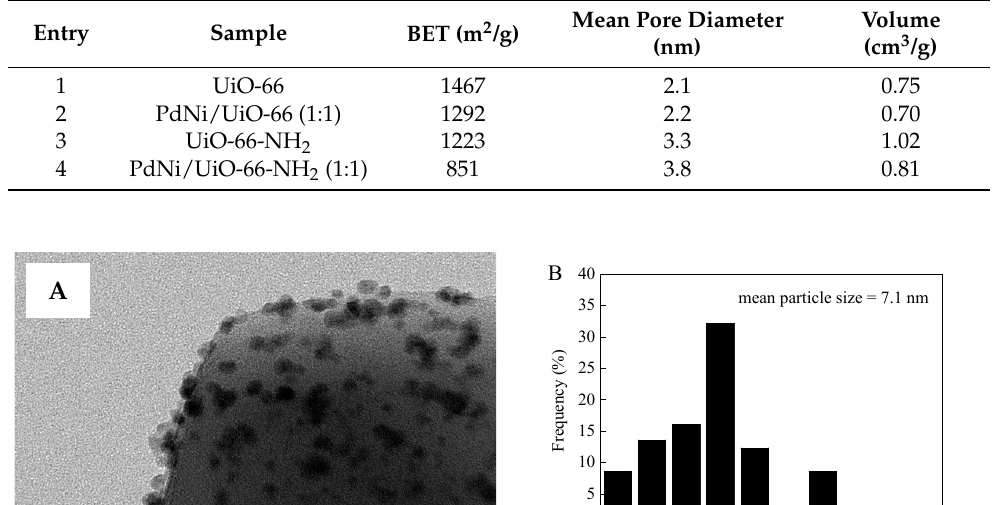
Figure 2. ( A ) TEM image, ( B ) PdNi size distribution, ( C ) STEM-HAADF image, and ( D – F ) EDS ele- mental mapping images of PdNi/UiO-66 (1:1).